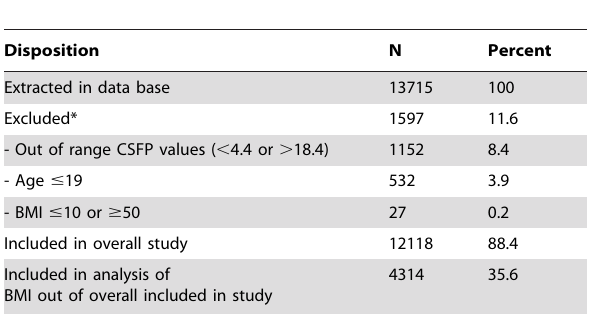
Table 3. Top ten primary diagnoses at visit of lumbar puncture for patients ages